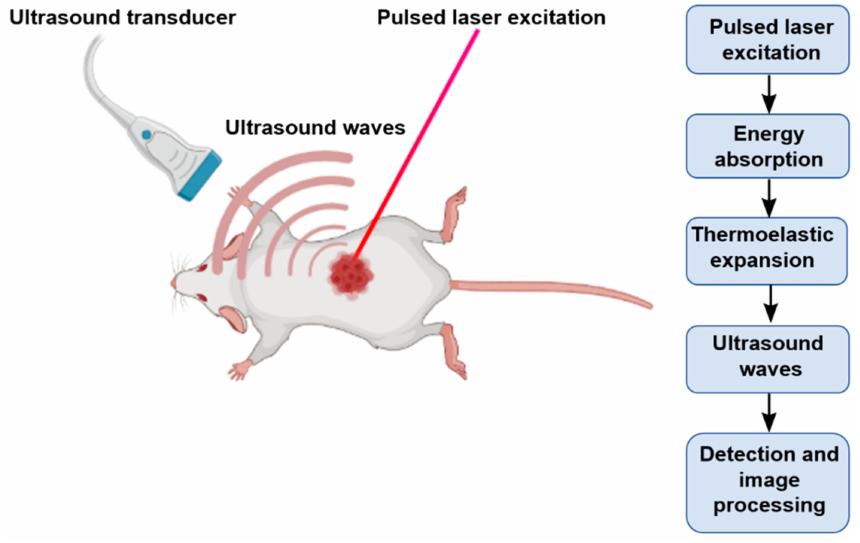
Figure 1. Schematic illustration of